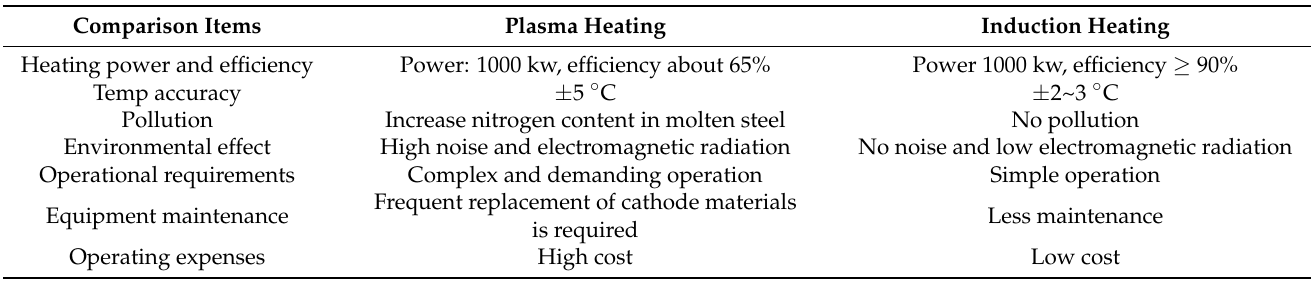
Table 1. Comparison between tundish plasma heating technology and electromagnetic induction heating